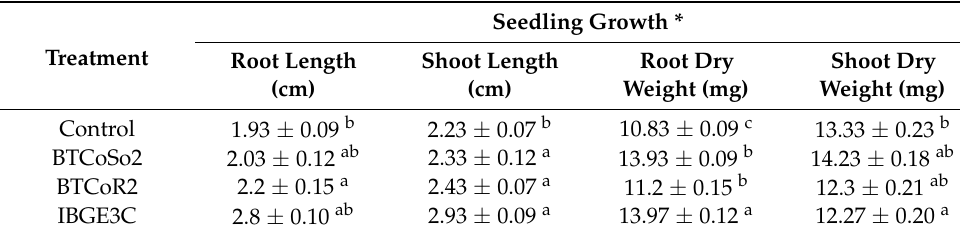
Table 3. Effects of bacterial isolates on seedling growth of BINAdhan-10 at 1% salinity. Values are mean and provided with standard error (significance level α = 0.05).